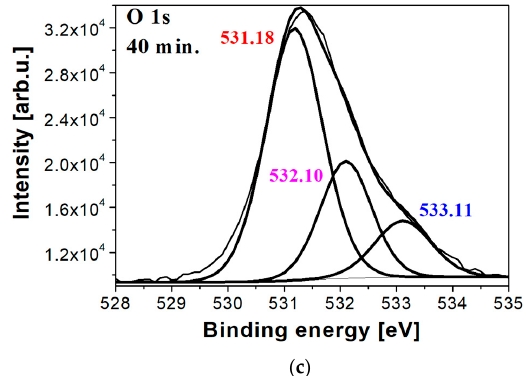
Figure 5. Deconvolution of the O 1s XPS spectrum of the ZGO film sputtered at 1.1 kV ( a ) before and ( b ) and ( c ) after Ar+ etching for 20 and 40 min, respectively